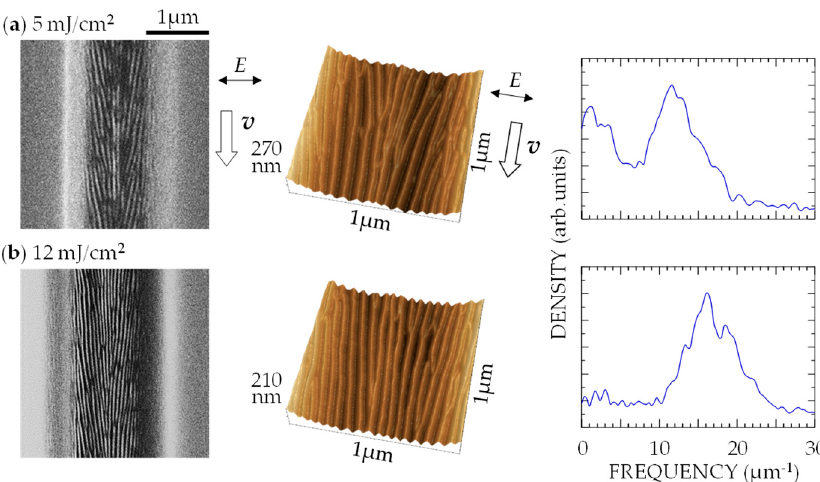
Figure 3. SEM images ( left ), SPM images ( center ), and spatial frequency spectra ( right ) of DLC film surface irradiated with 7-fs pulses at v = 0.1 μ m/s for ( a ) I = 0.8 TW/cm 2 , F = 5 mJ/cm 2 and ( b ) I = 2 TW/cm 2 , F = 12 mJ/cm 2 . E and v denote directions of polarization and laser scanning, respectively.